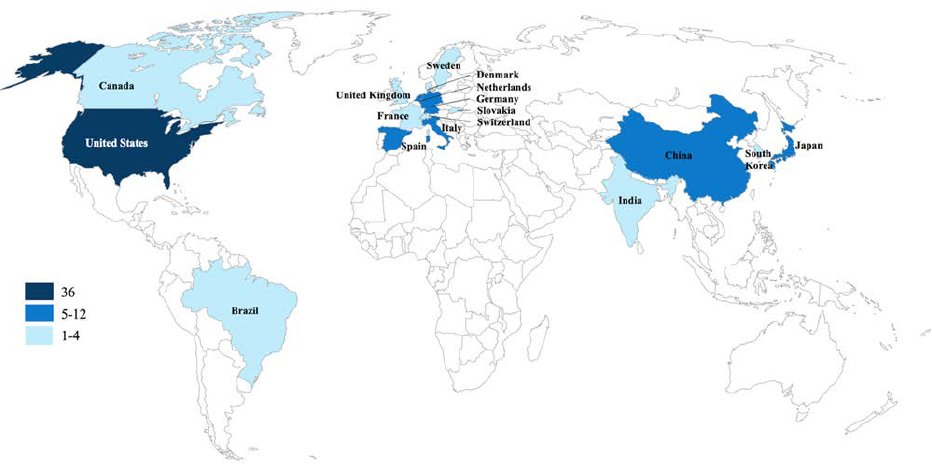
Figure 3. Geographic distribution of the top 100 most cited articles.